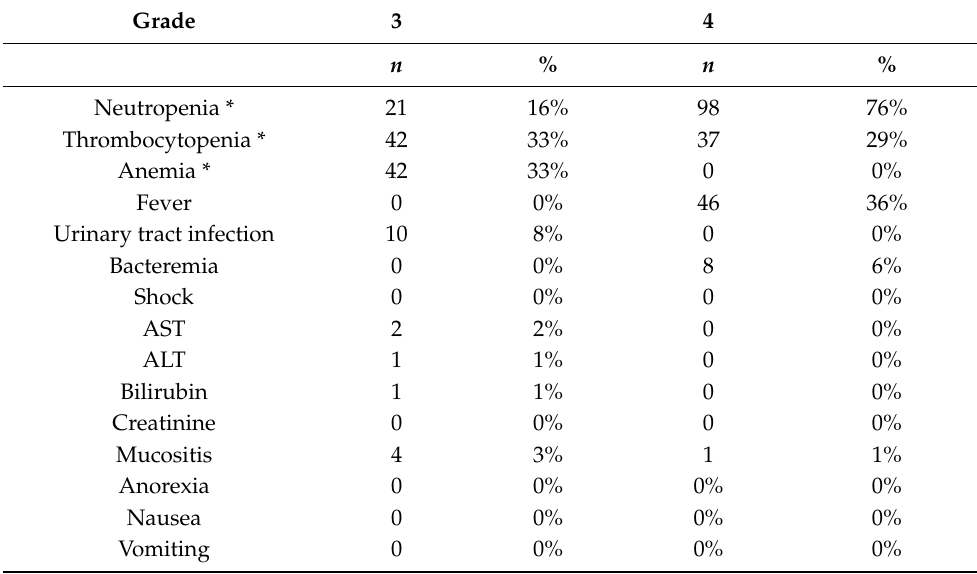
Table 2. Grade 3 and 4 toxicities observed during 129 cycles of ic-VDC/IE chemotherapy (number of cycles with the toxicities and their percentage of total cycles are